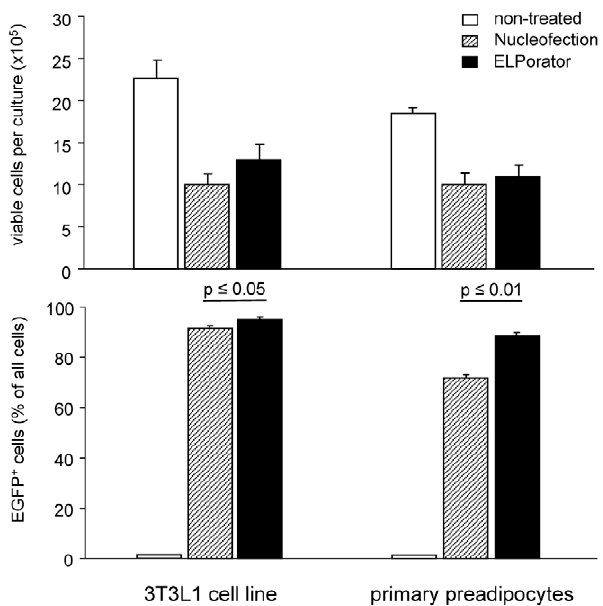
Figure 2. Transfection efficiency for adherent cells achieved by nucleofection compared to the ELPorator 1000 device. For transfection of 1 6 10 6 3T3L1 cells or preadipocytes from the mesenteric fat with 2 m g pEGFP-N1, a pulse combined of a HV pulse of 3 kV/cm for 400 m s followed by a LV pulse of 1.5 kV/cm for 5 ms was applied by the ELPorator 1000 device. Alternatively, cells were transfected using the Nucleofector Kit V and program T-030 in a device for nucleofection or remained untreated. After 24 h, cell recovery and viability were assessed by trypan blue exclusion. Transfection efficiency was determined by flow cytometry as percentage of EGFP + cells. Mean values 6 SEM; n=5.